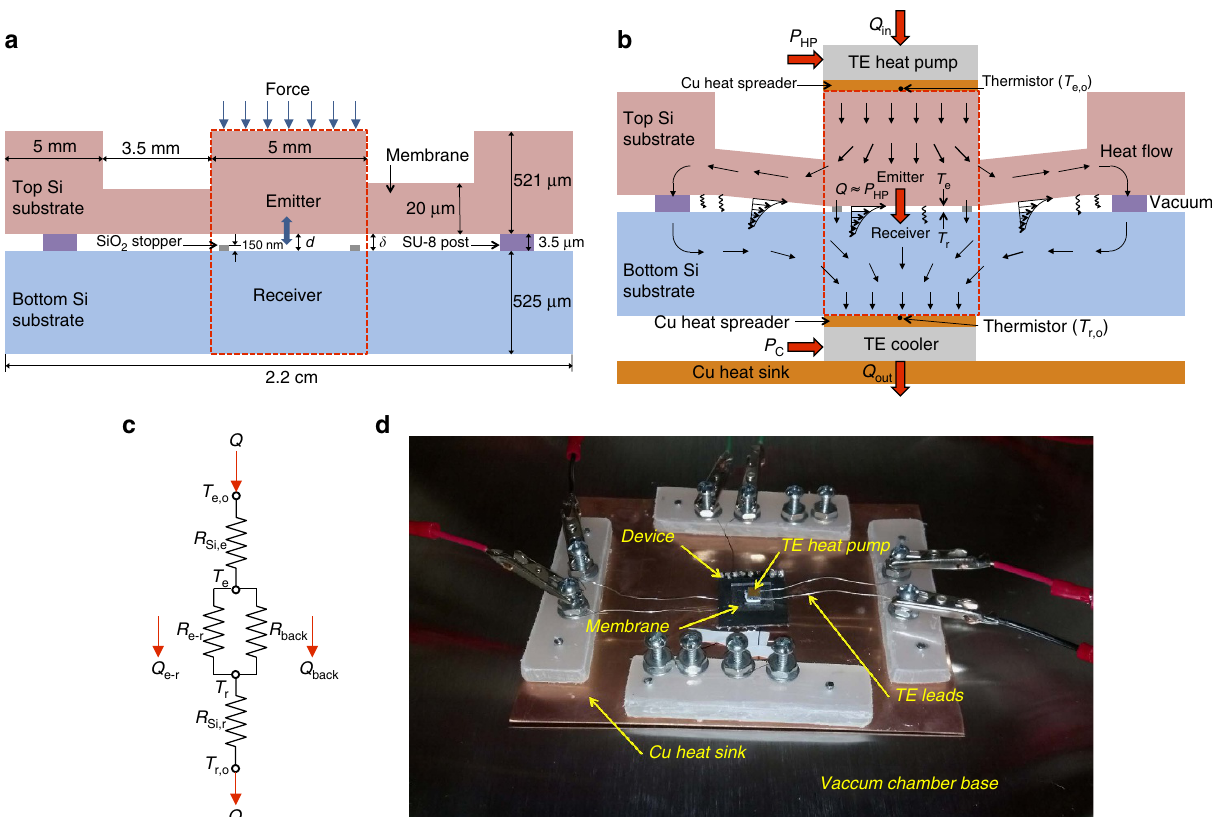
Figure 1 | Near-field radiative heat transfer device. ( a ) Device in the open position, where the emitter–receiver portion is identified by a dashed box. It consists of two silicon (Si) substrates separated by 3.5- m m-tall SU-8 posts. The gap between the emitter and the receiver, d , can be modulated by applying a force causing the membrane to flex. The minimum gap d is 150nm and corresponds to the height of the silicon dioxide (SiO 2 ) stoppers. The gap d is uniform under an applied force, while the gap outside the emitter–receiver region, d , is non-uniform when a force is applied to the device. The 1- m m-thick buried SiO 2 layer in the top Si substrate is not shown. ( b ) Heat flow through the device in the closed position. The temperature difference is maintained by a TE heat pump and a TE cooler supplying power of P HP and P C , respectively. P HP is approximately equal to the heat rate through the device, Q , since the heat rate Q in due to thermal emission by the surroundings is negligible with respect to P HP . Heat transfer between the top and bottom Si substrates occurs via radiation within and outside the emitter–receiver region and by conduction through the SU-8 posts and SiO 2 stoppers when the device is in the closed position. The temperatures T e,o and T r,o are measured by thermistors and are approximately equal to T e and T r , respectively. The device is mounted on a copper (Cu) heat sink dissipating heat, Q out , to the base of the vacuum chamber. ( c ) Equivalent thermal circuit of the device. R Si,e and R Si,r are the resistances of the Si emitter and receiver, R e–r is the resistance due to radiation between the emitter and receiver, R back is the resistance due to background heat transfer that includes radiation outside the emitter–receiver region as well as conduction through the SU-8 posts and SiO 2 stoppers. The heat rate flowing through the device, Q , is the sum of heat rates due to radiation between the emitter and receiver, Q e–r , and background heat transfer, Q back . ( d ) Photograph of the near-field radiative heat transfer device in the vacuum